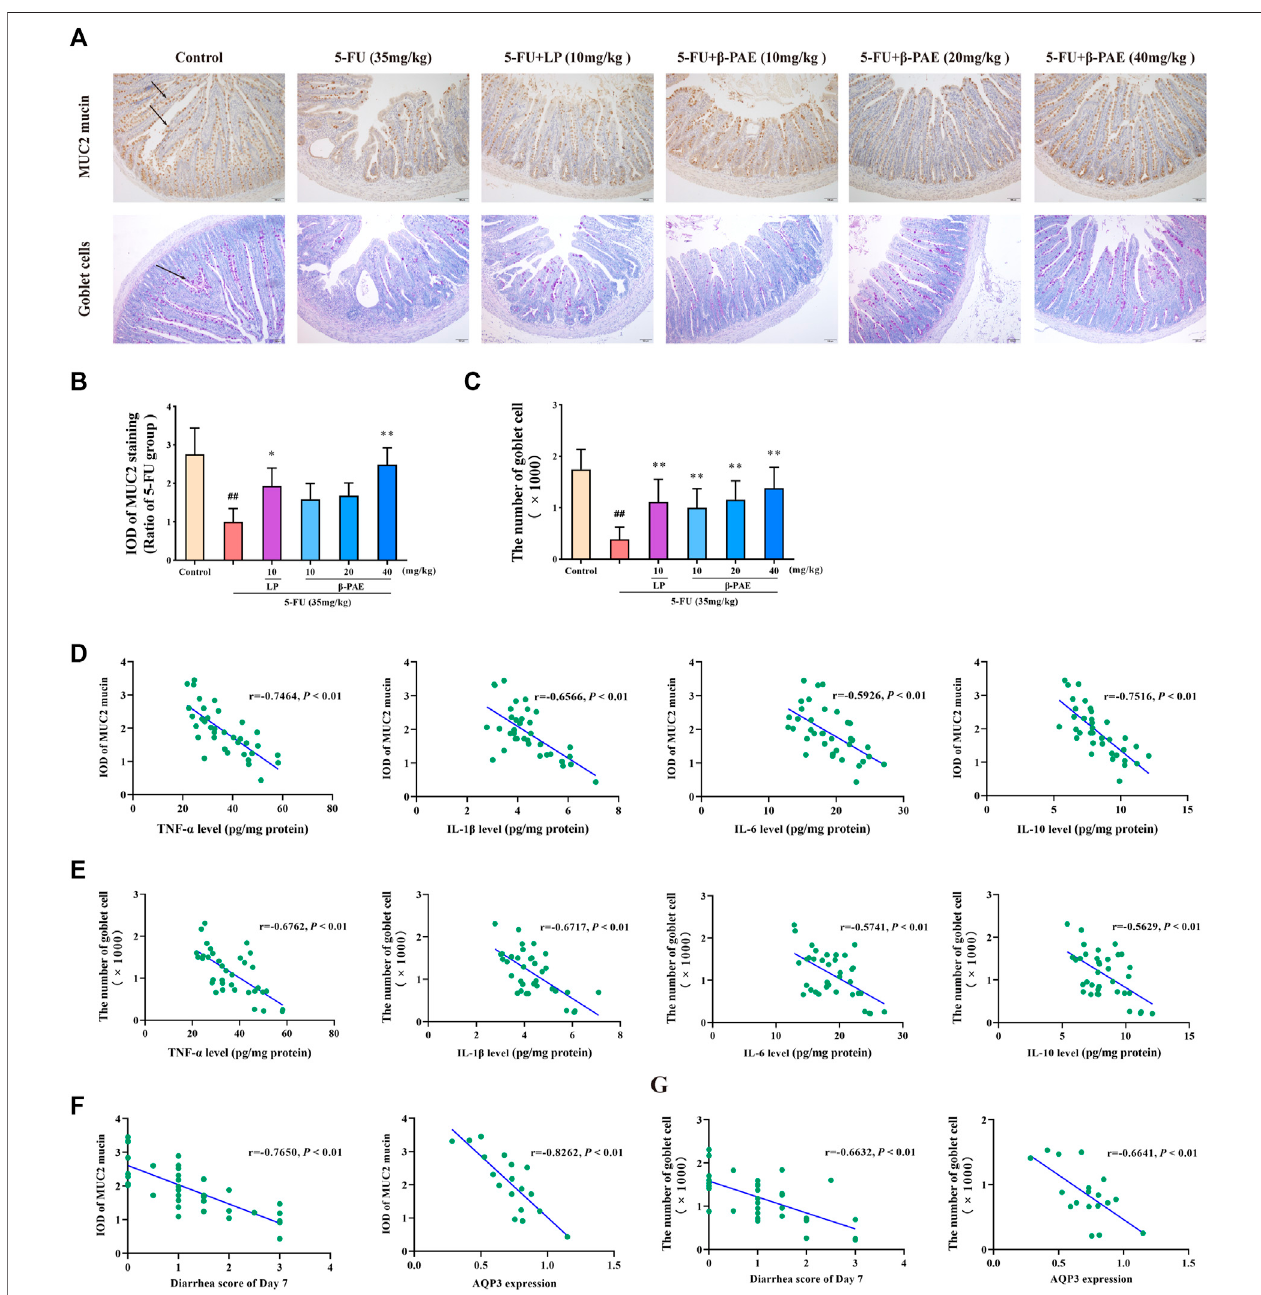
FIGURE7| Effectsof β -PAEonmucuslayer. (A) MUC2mucinproteinandgobletcellsinthesmallintestine(magni fi cation100x),thearrowsindicatepositiveprotein expression; (B) IOD of MUC2 mucin expression; (C) The number of goblet cells; Spearman ’ s correlation analysis (D) between MUC2 mucin protein expression and in fl ammatorycytokineslevel; (E) betweengobletcellsandin fl ammatorycytokineslevel; (F) betweenMUC2mucinexpressionanddiarrhea symptoms;andAQP3levels; (G) between goblet cells and diarrhea symptoms; and AQP3 levels. Data are shown as mean ± SD ( n (cid:2) 6). ## p < 0.01 versus control group; * p < 0.05, ** p < 0.01 versus 5-FU